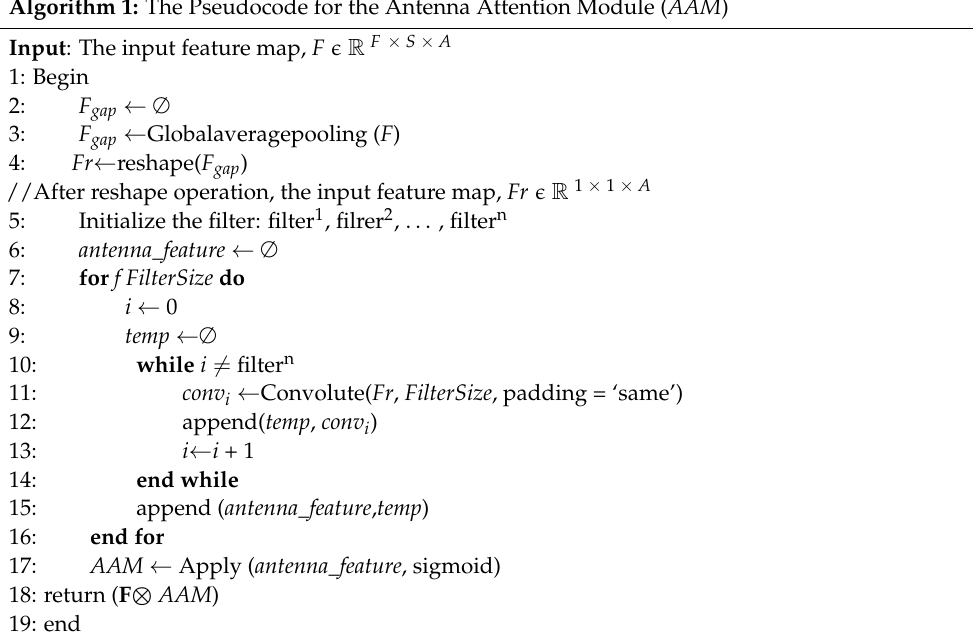
Algorithm 1: The Pseudocode for the Antenna Attention Module ( AAM